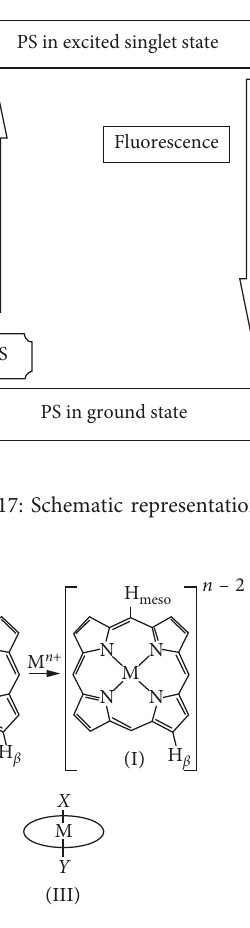
Figure 18: Schematic mechanism of a porphyrin complex pre- senting a tetra-coordinated metal in its tetrapyrolic core. (i) Metal trans -coordinated to two ligands. (ii) Simplified presentation.